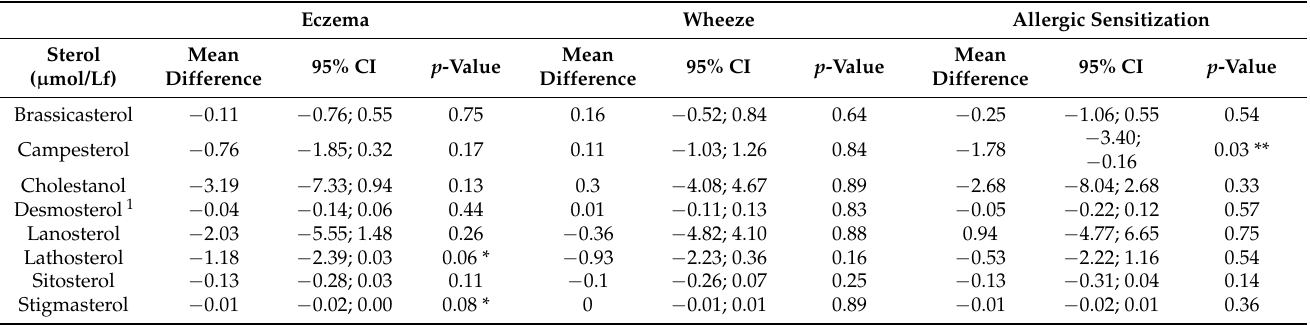
Table 4. Results of the independent-sample t -tests to explore differences between non-cholesterol sterol concentrations in breast milk between cases and controls for eczema ( N = 80 cases, N = 179 controls), wheeze ( N = 67 cases, N = 195 controls), and allergic sensitization ( N = 41 cases, N = 130 controls). Non-cholesterol sterol concentrations were adjusted for